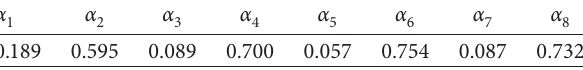
Table 1: Values of reflection coefficients [38].